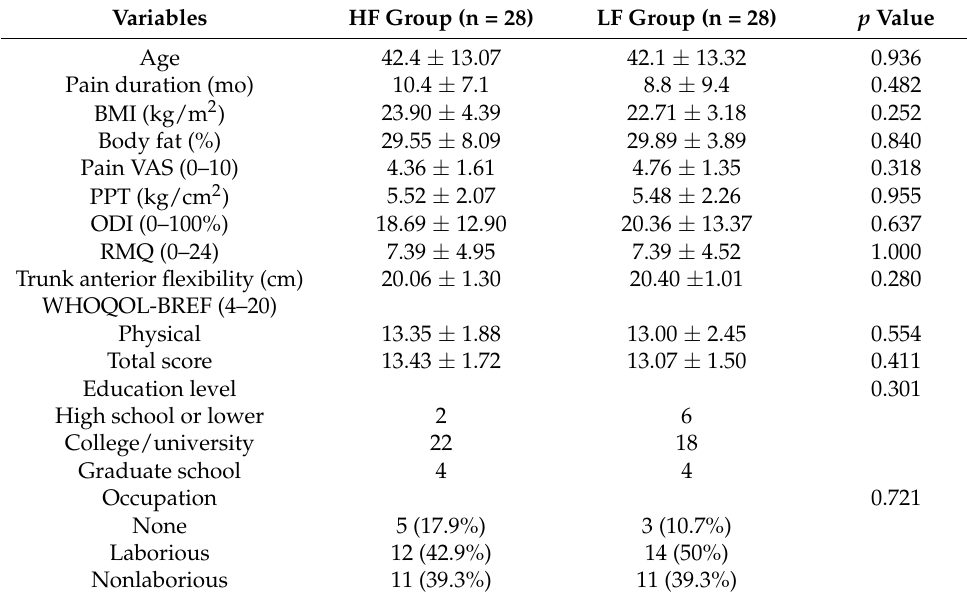
Table 1. Baseline Characteristics of the